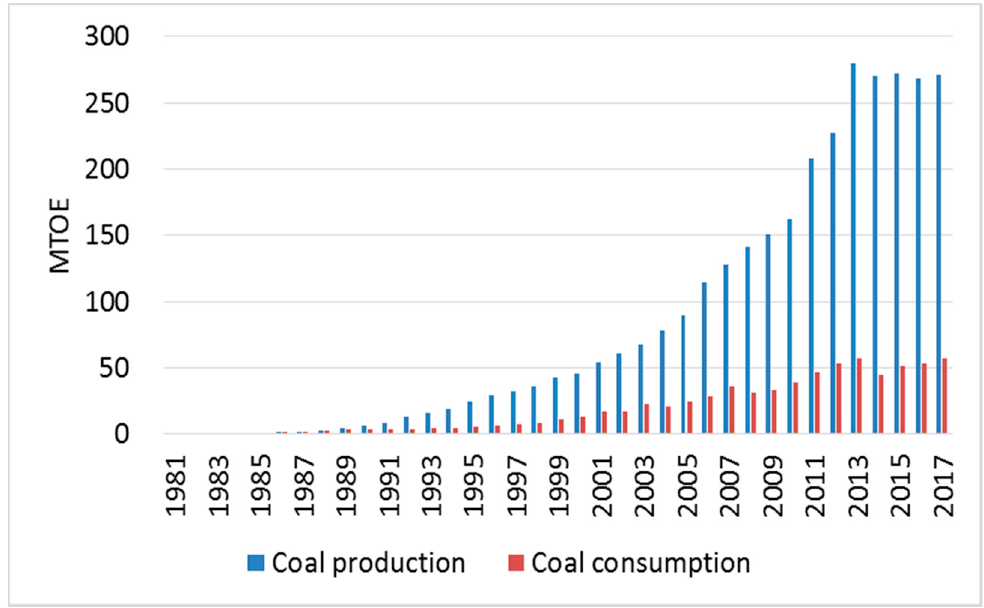
Figure 4. Coal production and consumption, adapted from: BP [27].